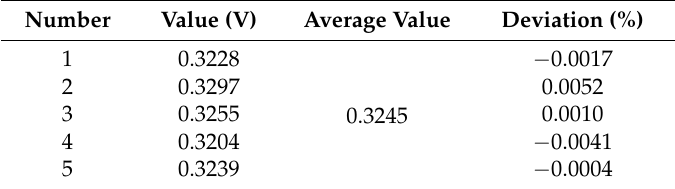
Figure 10. Image of dry chemical diagnostic reagents in vitro. Table 1. Light reflection signal values of dry chemical diagnostic reagents in vitro.